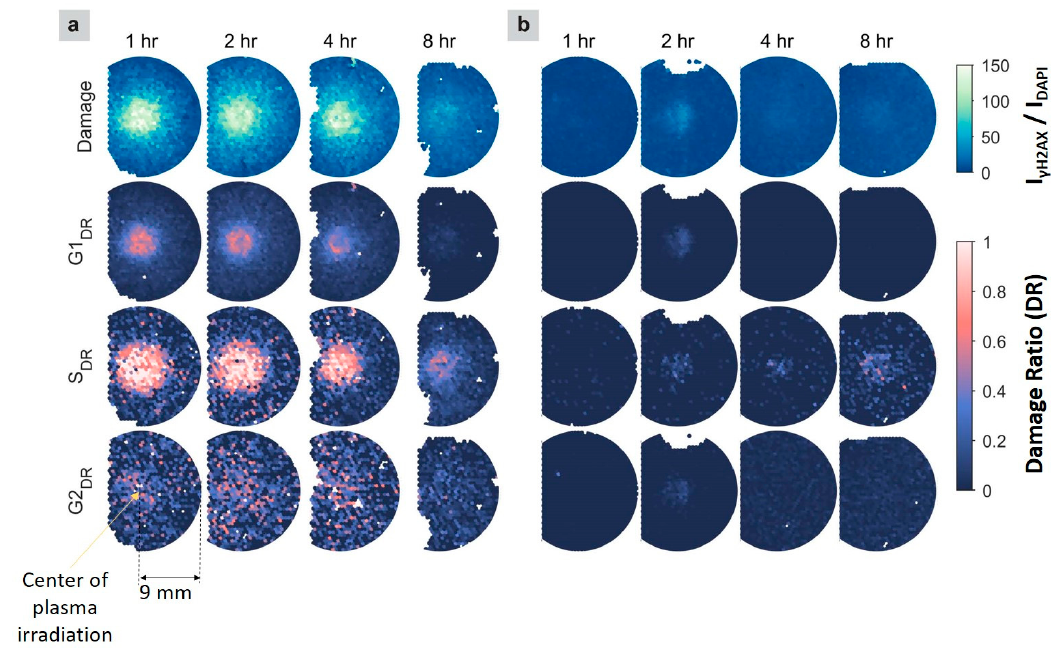
Figure 3. 2D distributions of the damaged DNA fraction in each nucleus (top row) and the damage ratios (DRs) for cells in G1, S, and G2 phases (rows 2–4), based on γ H2AX staining in malignant cells ( a ) and nonmalignant cells ( b ) grown on coverslips. The damage threshold used to determine the DR was 75 (noting the damage range is 0–150). Each circular distribution, with a diameter of 18 mm, is centered on the treatment locations. Locations with white patches indicate regions without cells or blurry regions of the image, which were discarded. The circles for the cancer cells are cut off on the left side, due to a limitation of the slide scanner.